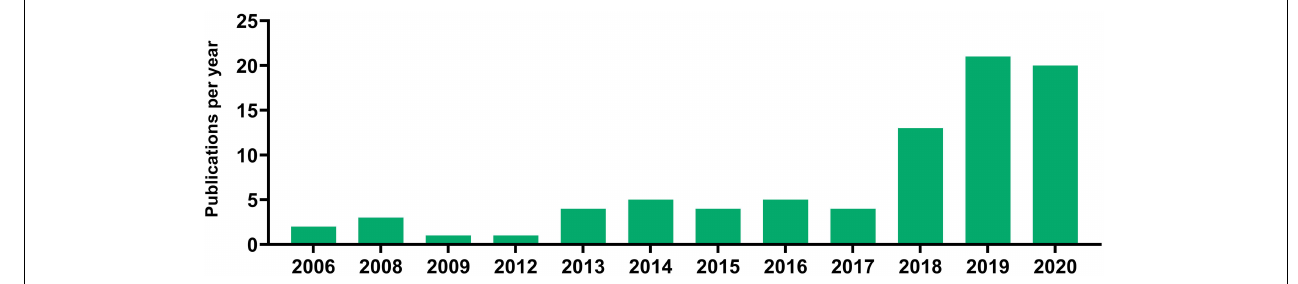
FIGURE 3 | Articles published investigating the impact of various protocols on cfDNA research and analysis.